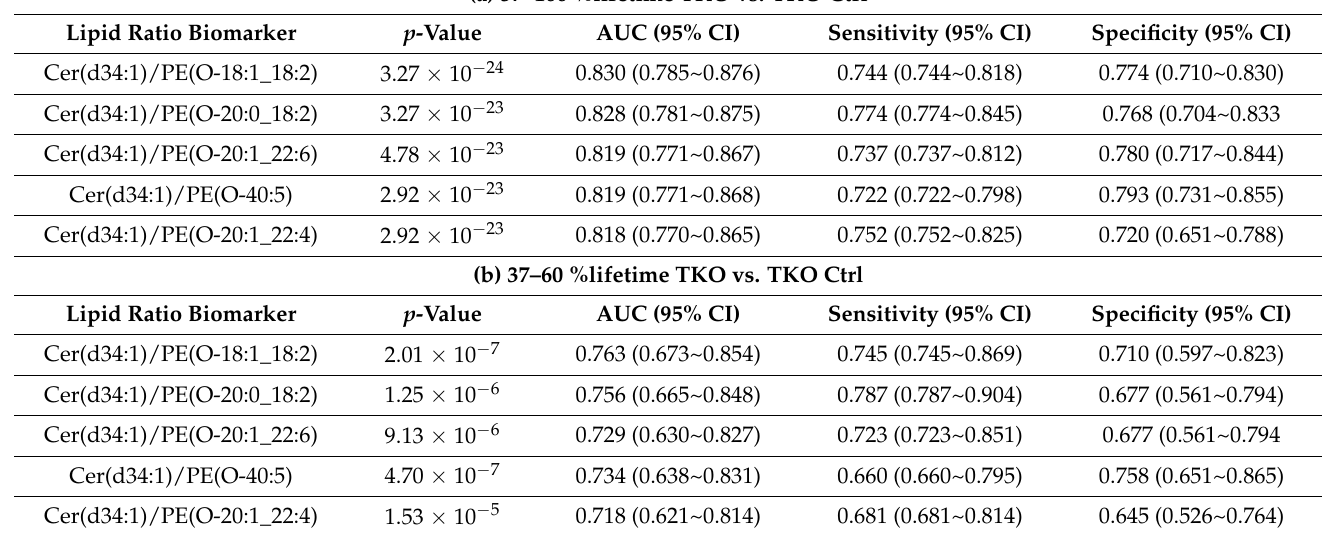
Table 3. Selection of lipid ratio abundance biomarkers based on their significant differences between TKO and TKO control samples. The selected ratios were validated with a 10-fold cross-validated logistic regression model. The area under the curve (AUC), sensitivity, and specificity are shown for (a) all TKO and TKO controls samples in the 37–100 %lifetime group (b) TKO and TKO controls in 37–60 %lifetime group. CI: confidence